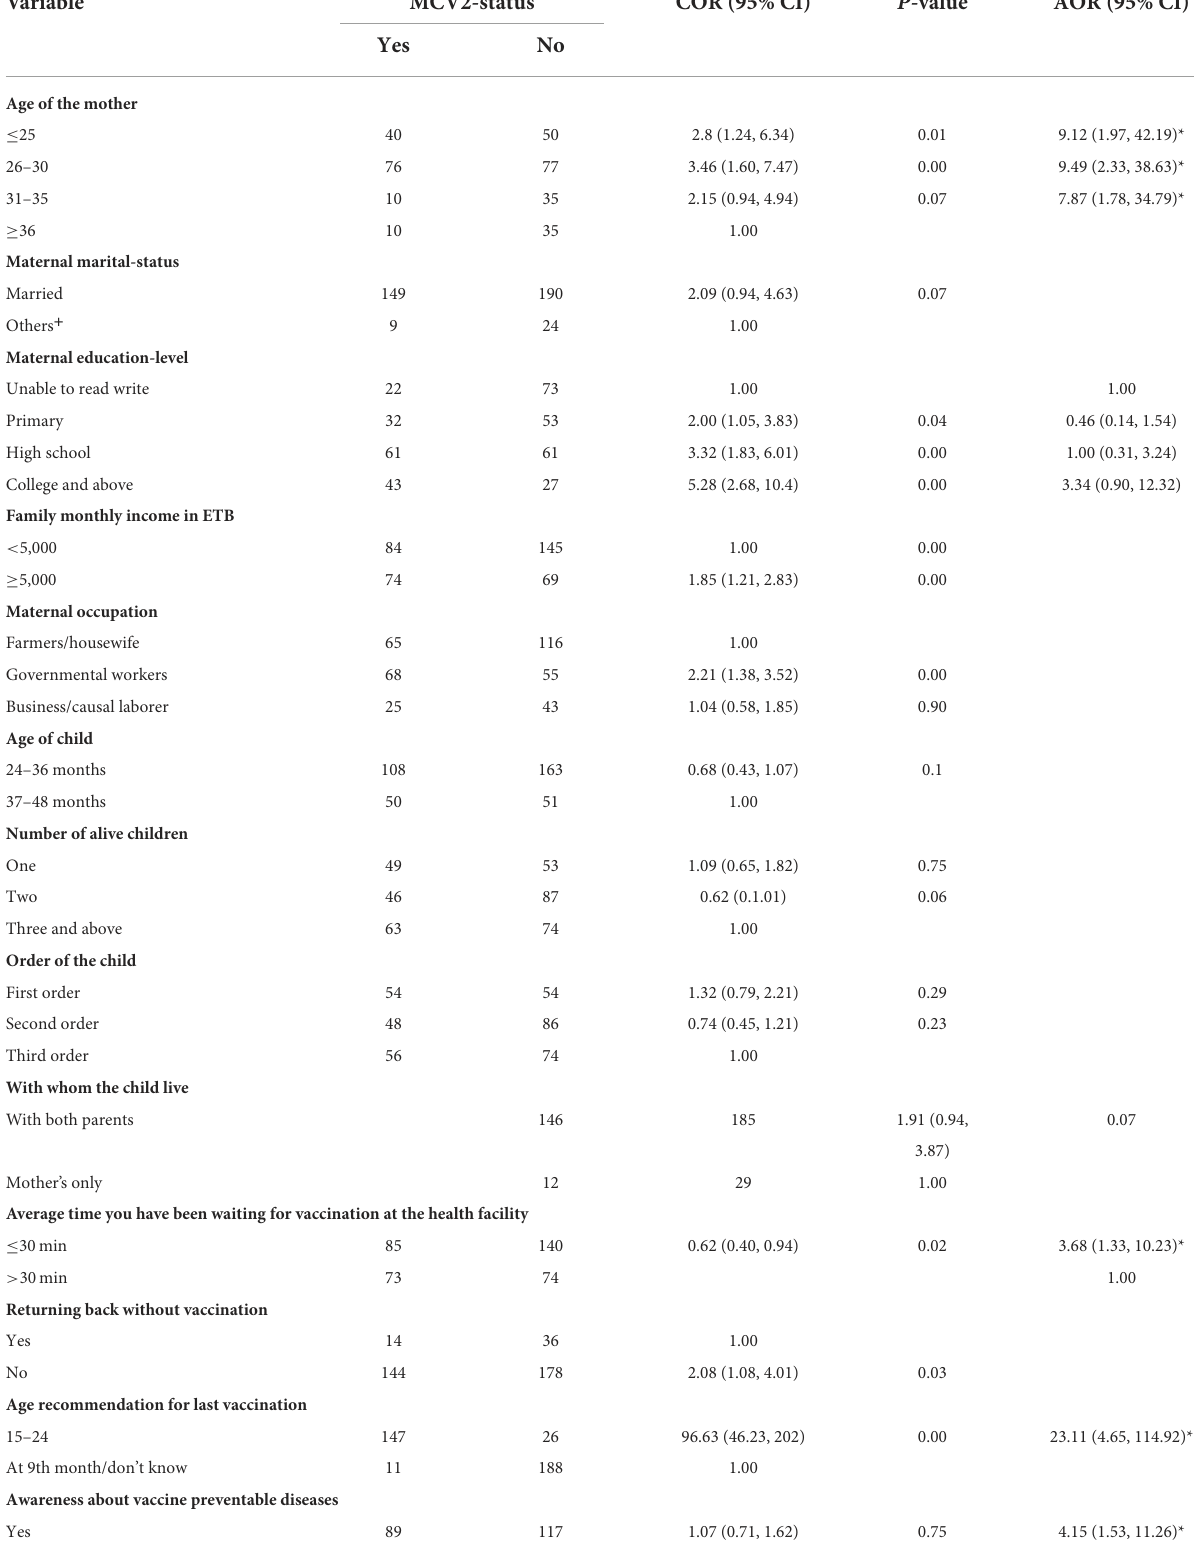
TABLE 4 Bivariable and multivariable logistic regression among study participants on MCV2 vaccination and associated factors in urban areas of North Shoa Zone, Oromia Region, 2022.